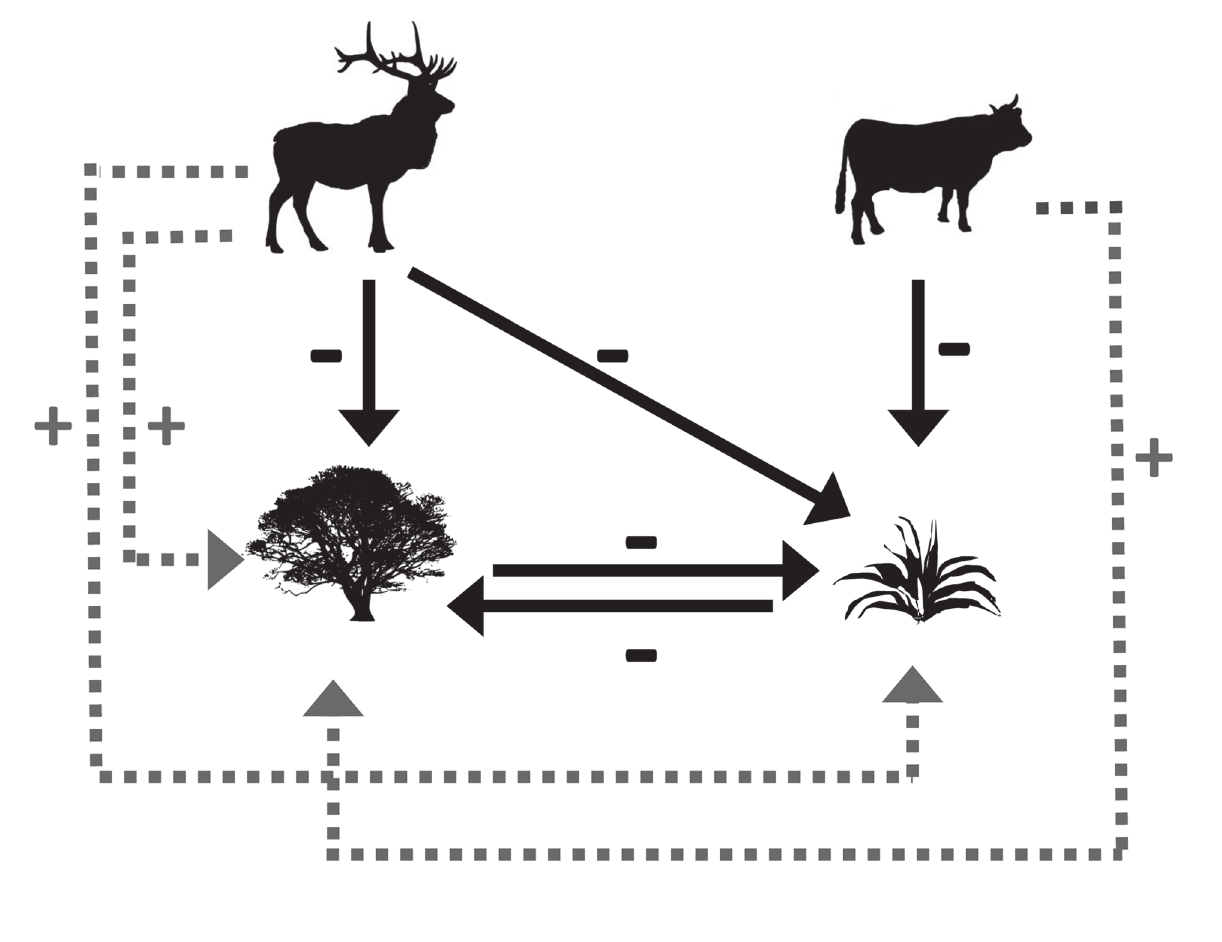
Fig 1. Conceptual model. Conceptual model of interactions among browsing, grazing, woody plants, and perennial grasses. Model assumes that wild ungulates (top left) will both browse and graze, while cattle (top right) will primarily graze. Solid arrows indicate direct effects and assume net negative effects of herbivory and competition on plant biomass. Dashed arrows indicate indirect effects of browsing and grazing mediated through competition between woody plants (bottom left) and perennial grasses (bottom right). Browsing and grazing, depending on their timing, intensities, interactions, and net effects, can shift plant communities between woody- and grass-dominated